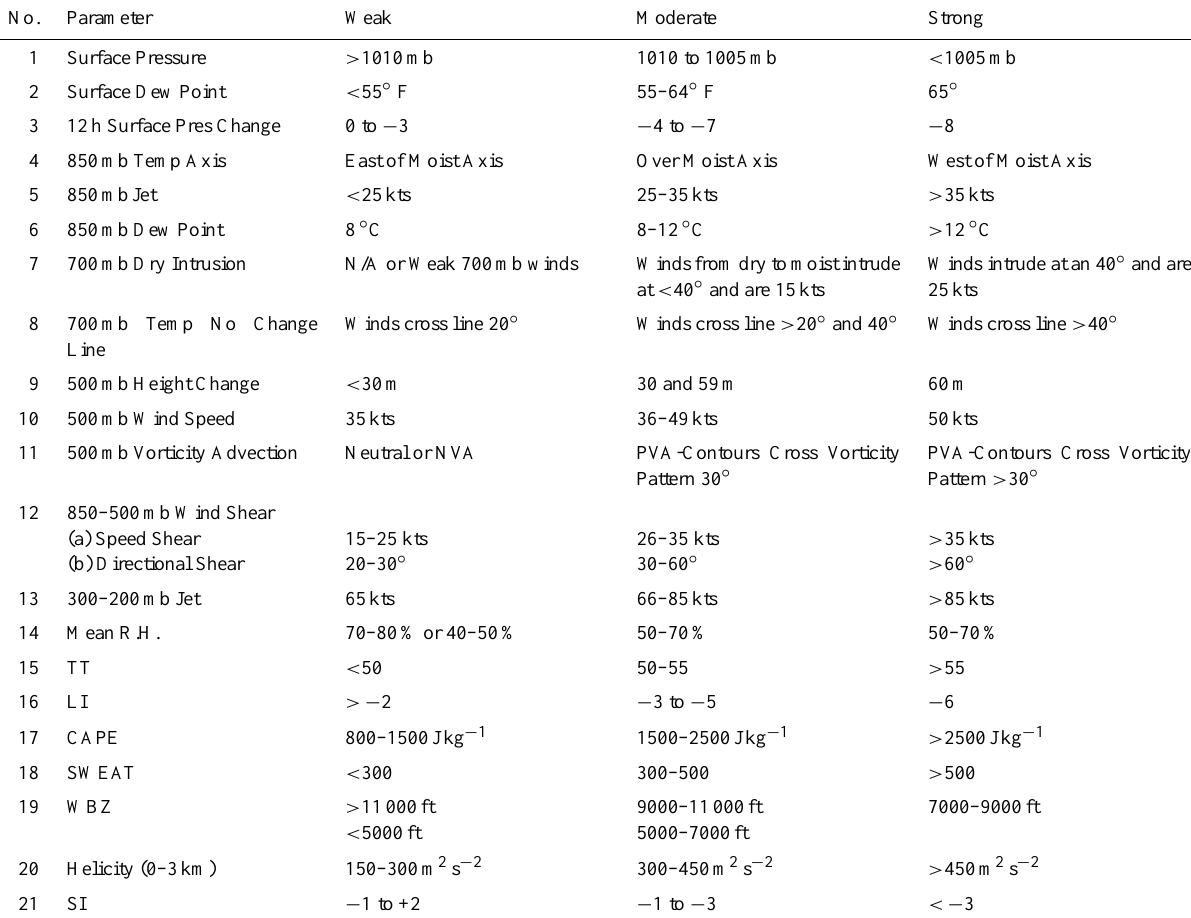
Table 4. Miller severe weather